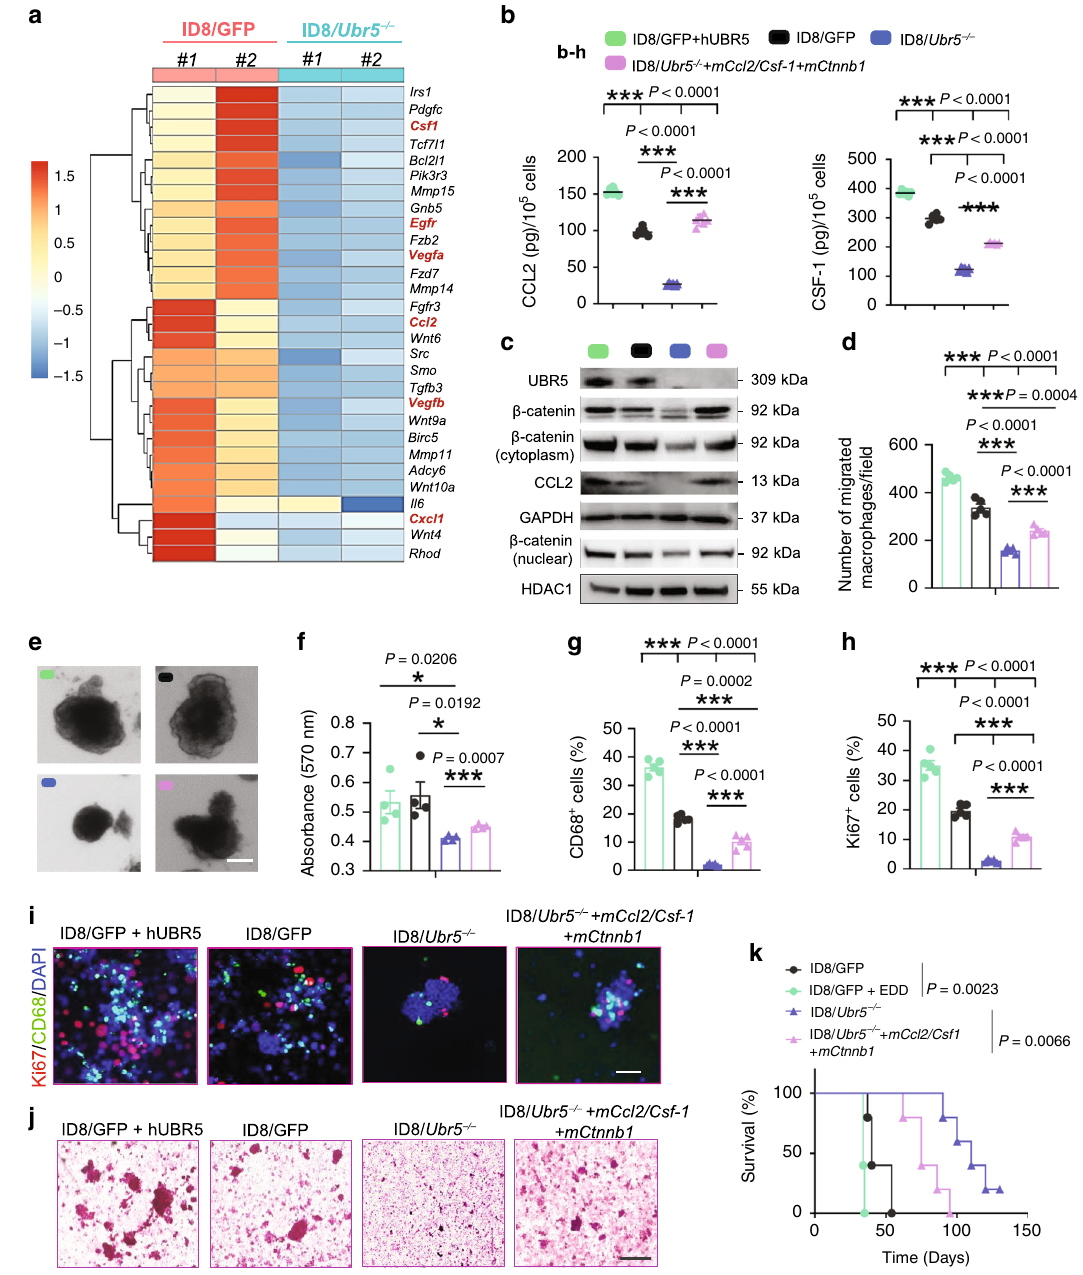
Fig. 6 Effects of tumor-derived paracrine factors on TAMs and spheroids. a Heat map representation of differentially expressed genes involved in macrophage recruitment, Wnt signaling, and cell adhesion in recovered peritoneal cells from ID8 bearing mice. b ID8 cells were cultured in DMEM overnight and the protein levels of CCL2 and CSF-1 in cell cultures were measured by ELISA ( n = 5 – 6 biologically independent samples per group). c Western blotting showing the protein expression of UBR5/ β -catenin/CCL2 in different ID8 cells. d Peritoneal macrophages were harvested and seeded into Transwell inserts with ID8 cell cultured in the bottom. Migrated macrophages were quanti fi ed after 16h-incubation ( n = 5 biologically independent samples per group). e Representative images of spheroids. Scale bars: 200 μ m. f Quanti fi cation of spheroid expansion rates ( n = 4 biologically independent samples per group). g , h CD68 + cells and Ki67 + cells in spheroids were quanti fi ed ( n = 4 mice per group). i Representative images of CD68 + macrophages and surrounded Ki67 + cells. ( n = 4 mice per group and ten confocal images acquired from each sample). All panels are the same magni fi cation, scale bars: 50 μ m. j Spheroid retrieved from ID8 bearing mice at day 30 were underwent H&E staining ( n = 4 mice per group and an average of fi ve fi elds acquired from each sample). Scale bars: 200 μ m. k Survival in mice bearing ID8 tumors ( n = 5 mice per group), log-rank test. All data are representative of at least two independent experiments with similar results. Data are presented as mean ± SEM, unpaired two-sided Student ’ s t -test with no correction for multiple comparison, * P < 0.05, ** P < 0.01, *** P < 0.001. Source data are provided as a Source Data fi